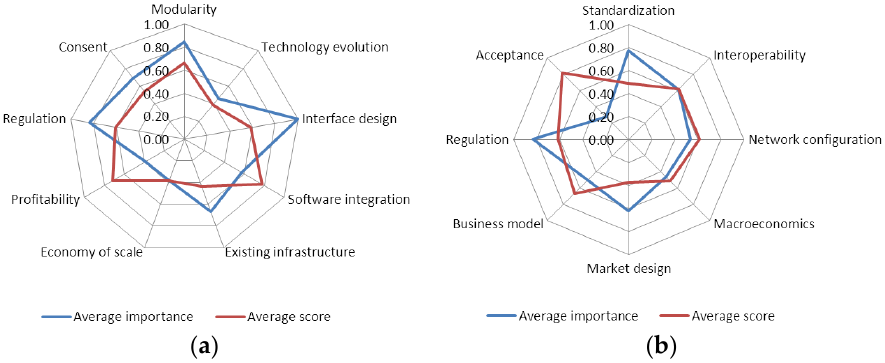
Figure 2. Average scores and average importance of ( a ) scalability and ( b ) replicability factors.